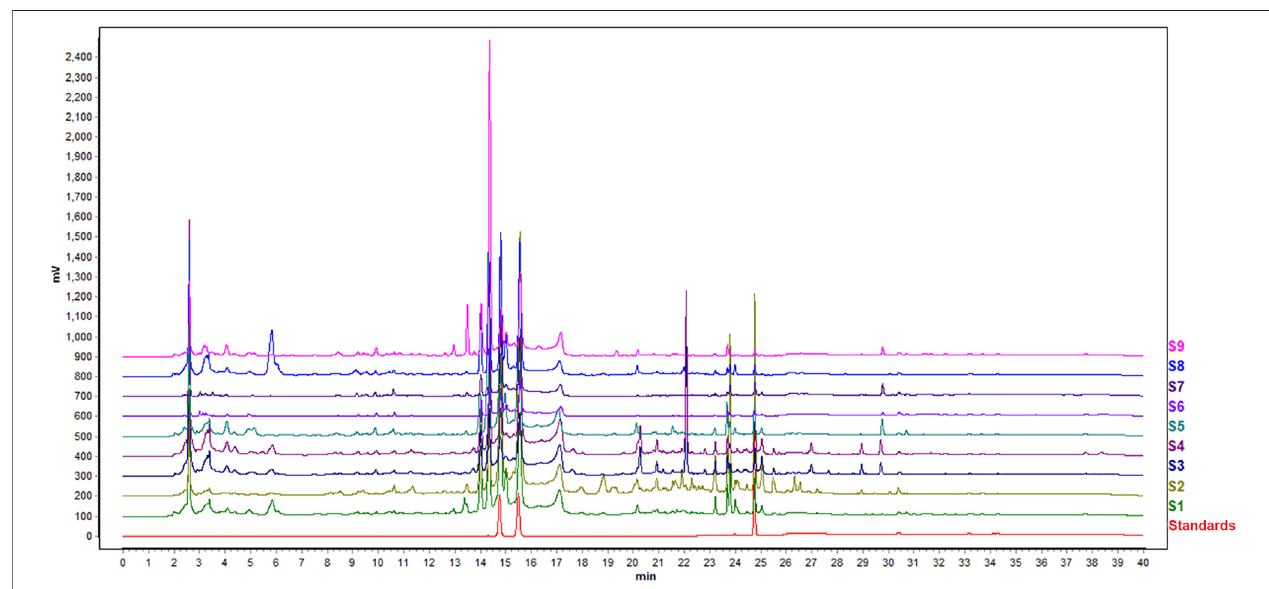
FIGURE 2 | HPLC fi ngerprints of nine sets of Epimedium samples studied and standards (epimedin C, icariin and baohuoside I, from left to right).